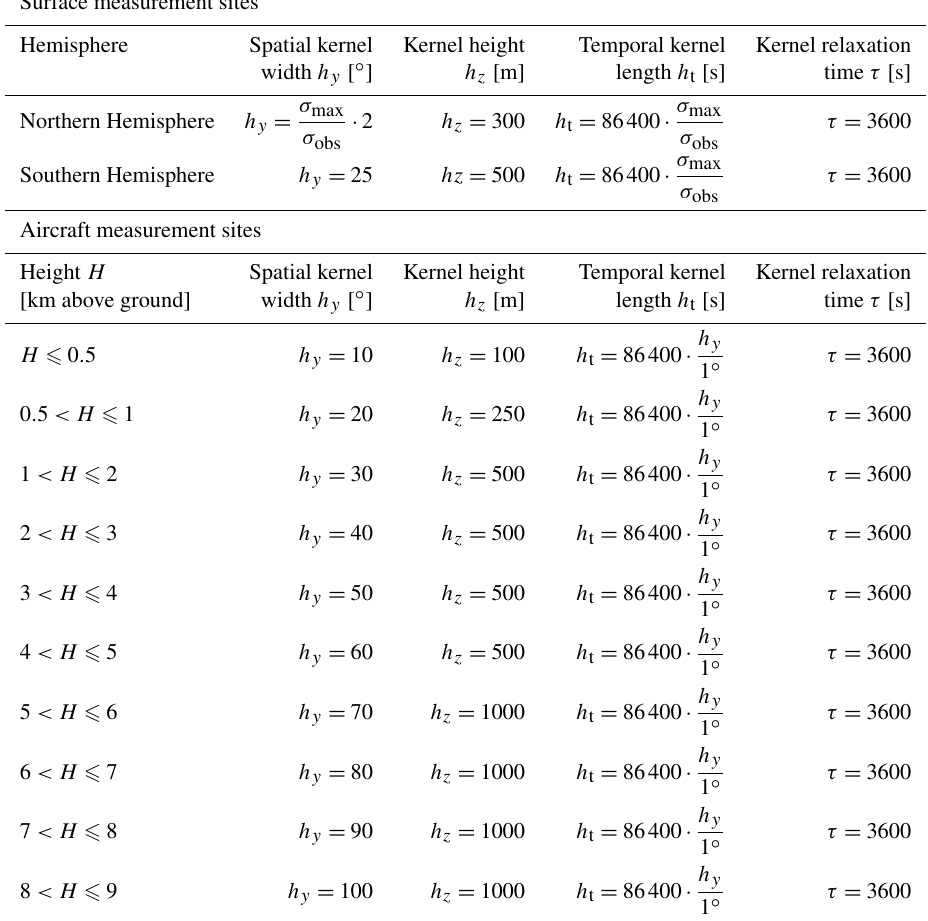
Table A4. Nudging kernel settings for surface and aircraft measurement sites. The kernels are set to have an equal spatial length (in m) in the x and the y direction. For surface measurement sites in the Northern Hemisphere, an upper limit for h y was set to 25 ◦ ; σ obs defines the standard deviation of measurements over the simulation period at each nudging location; σ max describes the maximum value of σ obs from all surface observation stations. For aircraft measurement sites, the kernel size depends on the height level above ground H . For additional information on the parameters, see Groot Zwaaftink et al.